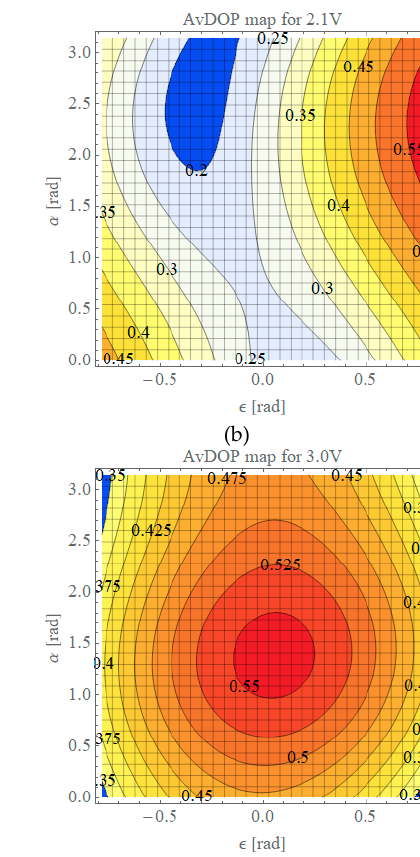
Figure 5. Calculated AvDOP maps for PVAN cells with thicknesses: 10 μ m ( a ) & ( b ) and 15 μ m ( c ) & ( d ) for following voltages and input SOPs ( a ) 1.95 V & circular R, ( b ) 2.1 V & linear H, ( c ) 2.1 V & linear H and ( d ) 3 V & circular R.